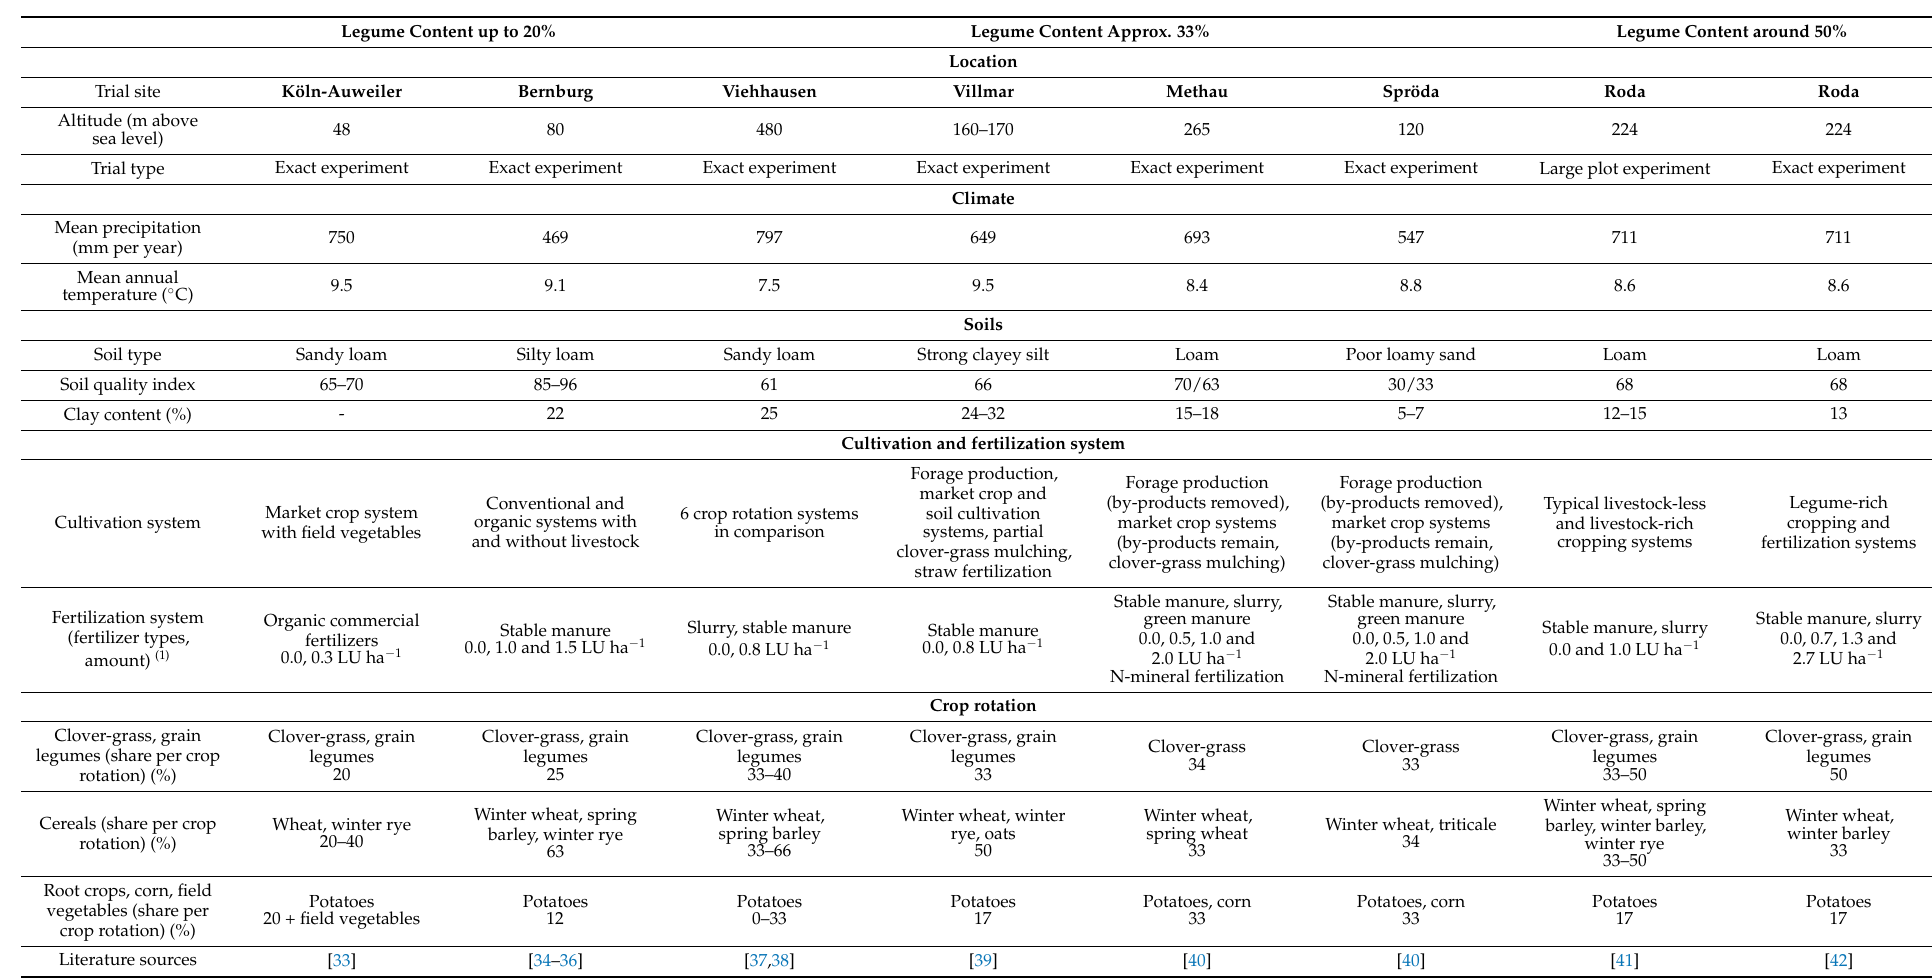
Table 1. Location, site, soil, and cropping factors of the participating long-term field trials with different amounts of legumes in the crop